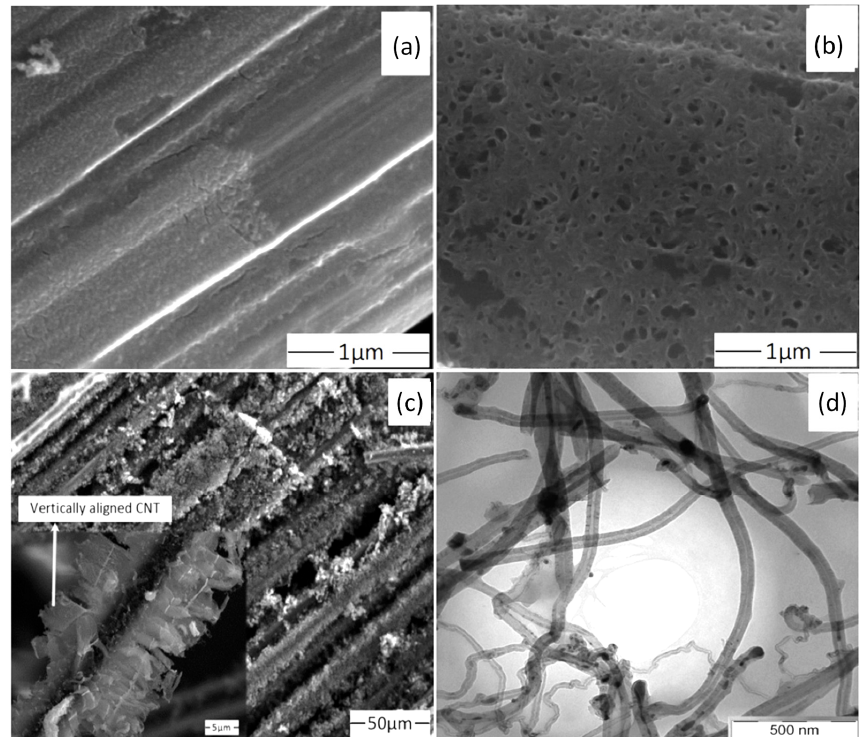
Figure 24. SEM micrographs of ( a ) before and ( b ) after calcination of CF coated with catalytic film, whereas ( c ) presents the same after CVD growth of VACNT with an insert at higher magnification. ( d ) TEM micrograph of CNT. Reprinted with permission from Rahmanian, Applied Surface Science; Ref. [120] copyright 2013, Elsevier.